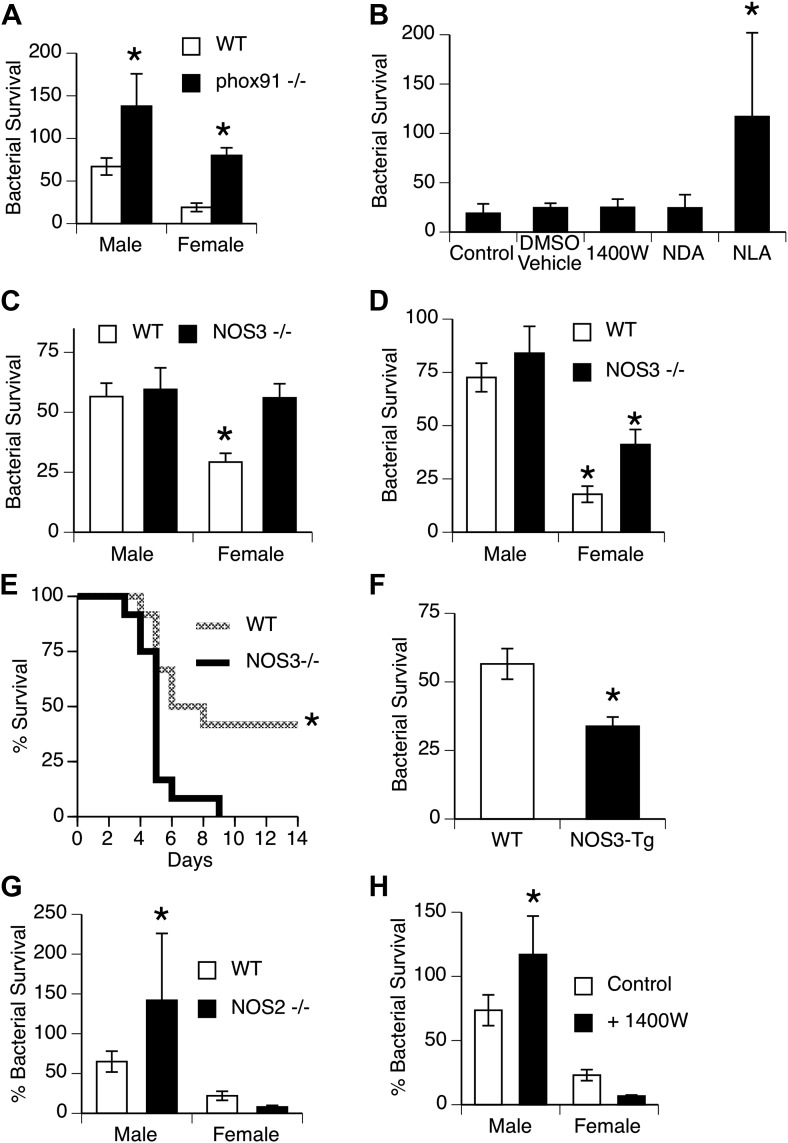
NOS3 and female resistance to pneumococcal pneumonia.(A) NADPH oxidase deficient (phox91−/−) mice show comparable reduction in bacterial clearance in both male and female mice (n = 6, * = p < 0.01 vs wild-type). (B) In vitro killing of pneumococci by normal mouse female AMs is inhibited by the non-selective NOS inhibitor nitro-L-arginine (NLA), but not by its inactive stereo-isomer, nitro-D-arginine (NDA), nor by the type 2 NOS specific inhibitor 1400W (n = 3–4, * = p < 0.01). (C) Female AMs from Nos3−/− mice lose the in vitro killing advantage of wild-type female AMs and show the same killing rate as wild-type or NOS3 deficient male AMs (n = 3, * = p < 0.01 vs wild-type). (D) In vivo, absence of NOS3 reduces, but does not completely eliminate, the female advantage in bacterial clearance (n = 15, * = p<0.015 vs all 3 other groups) and results in increased mortality from pneumococcal pneumonia (E) (n = 12 female mice per group, * = p < 0.01). Conversely, transgenic male mice with increased expression of human NOS3 show enhanced killing of S. pneumoniae in vivo (F) (lower bacterial survival, n > 5, * = p < 0.01). In this low-dose inoculum model, NOS2 deletion (G) or inhibition (H) causes reduced bacterial clearance in male, but not female mice (n = 8, * = p < 0.05).